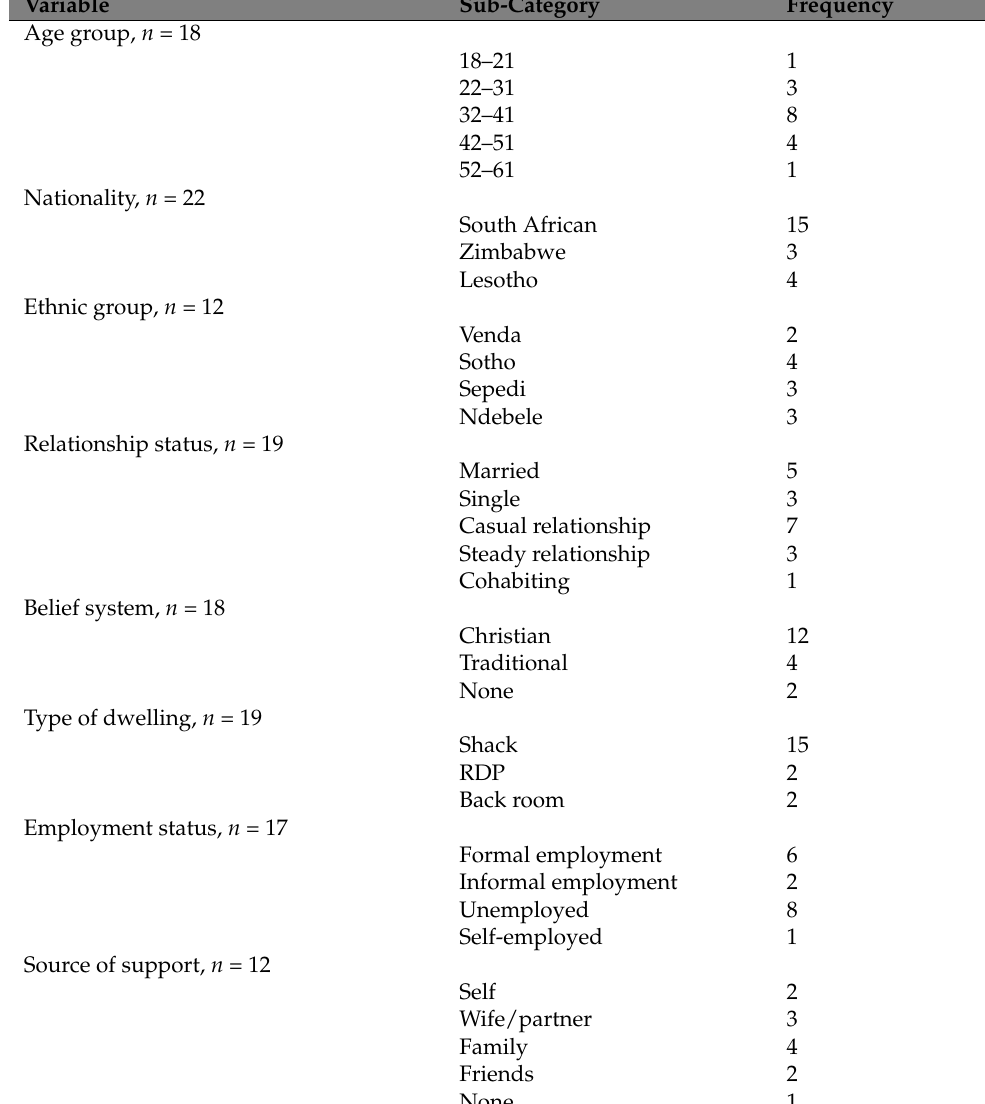
Table 2. Sociodemographic